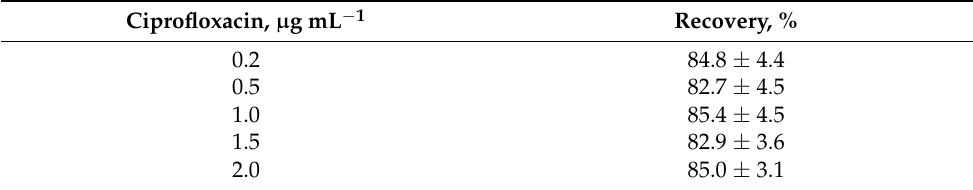
t -values for pairwise comparison: 0.432 (0.2 vs. 0.5 µ g mL − 1 ), 0.821 (0.2 vs. 1.0 µ g mL − 1 ), 0.477 (0.2 vs. 1.5 µ g mL − 1